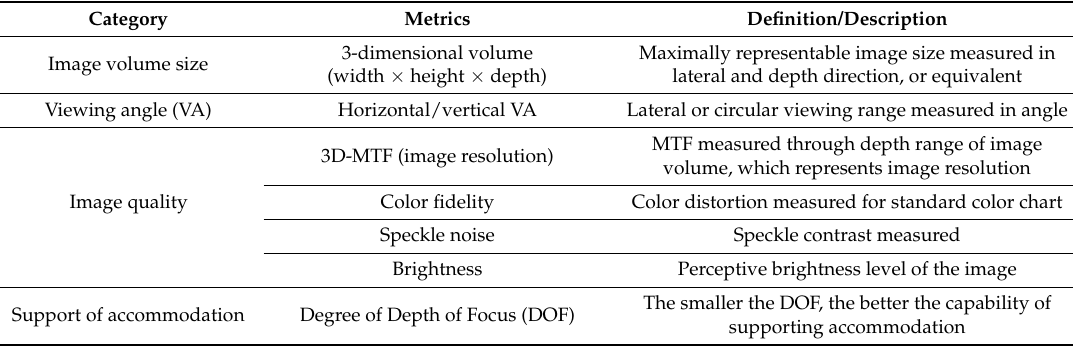
Table 4. Metrics and their definitions for holographic performance measure.